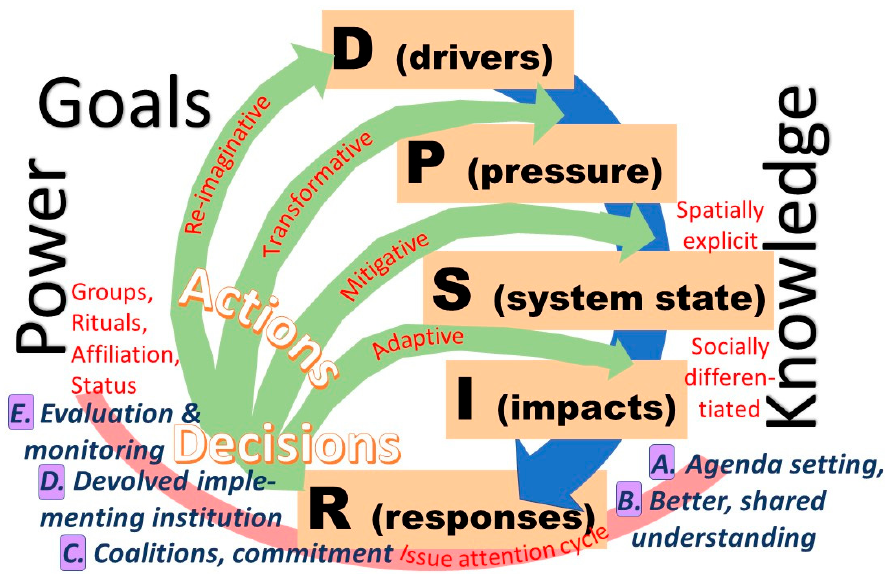
Figure 3. Drivers, pressures, system state, impacts and responses (also known as DPSIR) of landscape level change, with a decision cycle ( A – E ) closing various feedback loops interacting with knowledge, power and human sociality and its GRASP determinants.